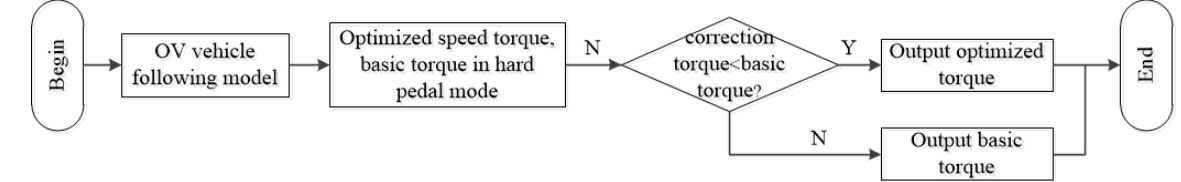
Figure 11. Calculation process for the optimized torque.